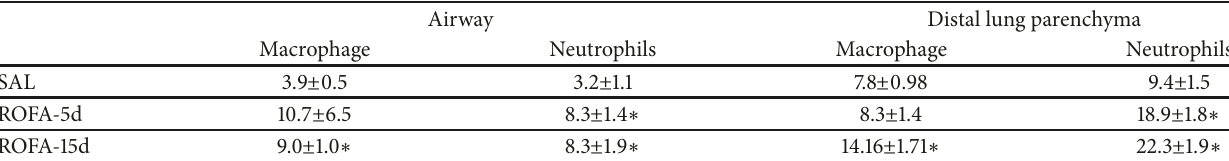
Table 2: ROFA-induced lung inflammation : after both five (ROFA-5d) and fifteen instillations (ROFA-15d), mice presented an increase in the numberof neutrophils and inflammatory cells that express nNOS and iNOS around airways and in distal lung parenchyma. The macrophages were significantly increased only in ROFA-15d groups compared to saline. ∗ P < 0.05 compared to saline.